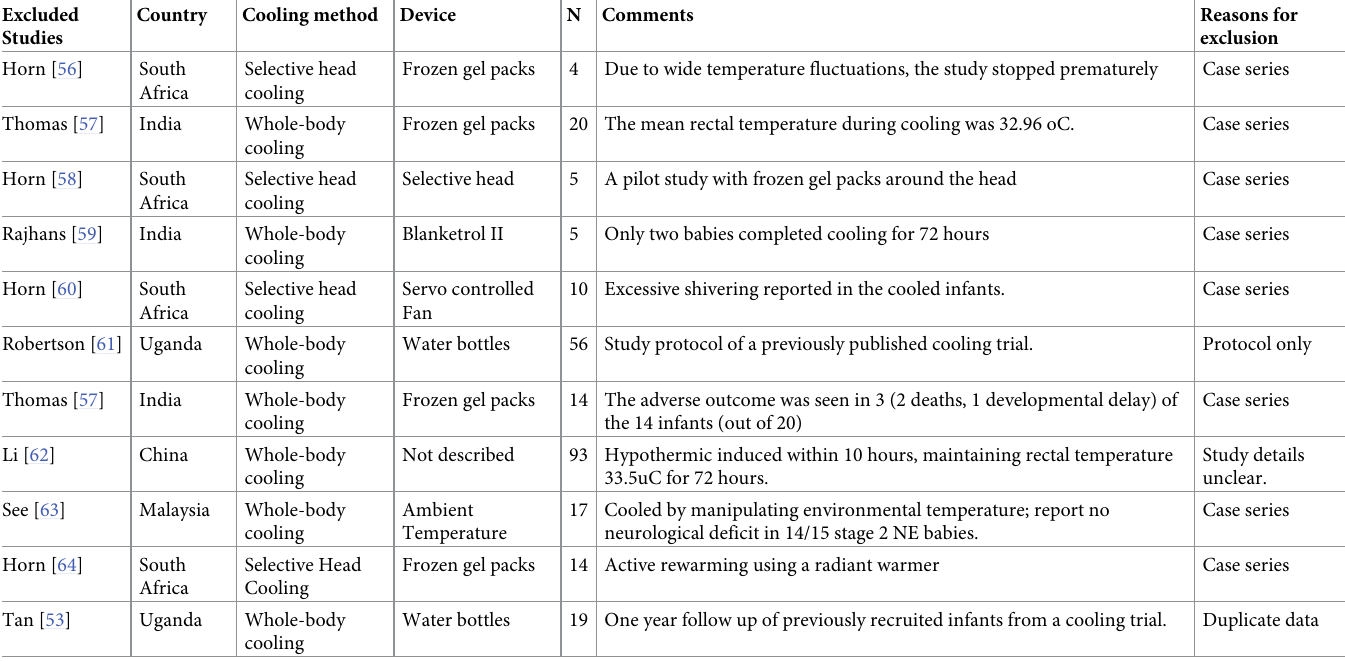
Table 3. Characteristics of excluded studies on the effects of therapeutic hypothermia on death among asphyxiated neonates with hypoxic-ischemic